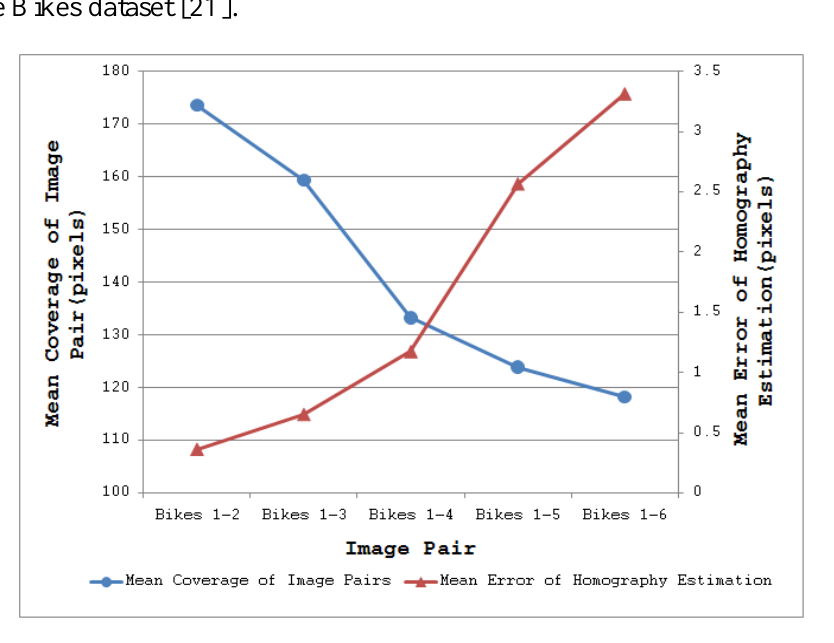
Figure 10. Curves for coverage and homography estimation error for MSER detector utilizing the Bikes dataset